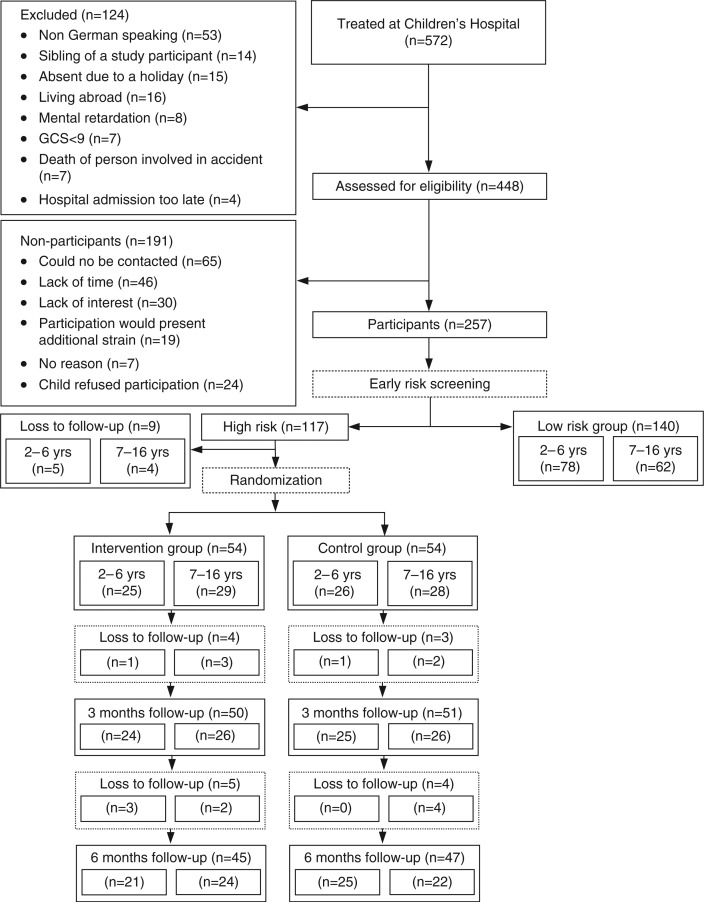
Participant flow chart.